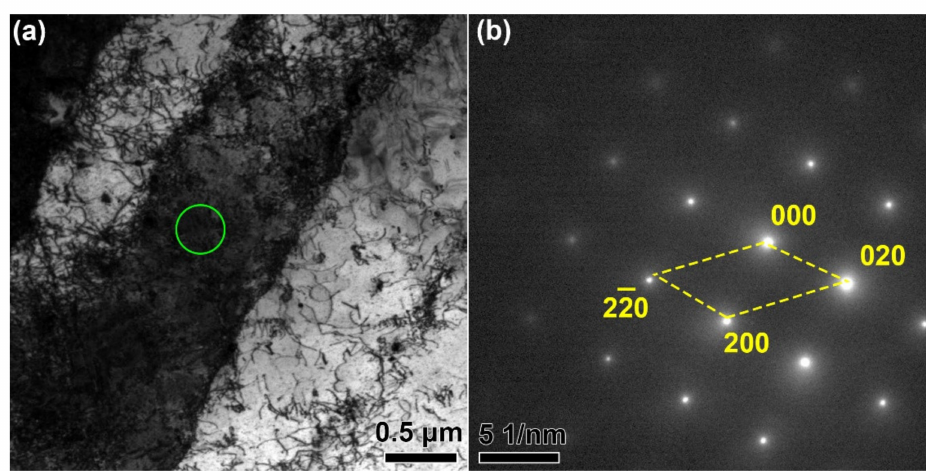
Figure 4. TEM images showing the microstructure of as-built GTD222. ( a ) The bright field image of the GTD222, ( b ) selected area electron diffraction of green circle area marked in ( a ). In the HTed GTD222, the tangled dislocations were disappeared and γ ’ was precipi- tated, as shown in Figure 5a,b. The precipitated γ ’ was further identified by the dark-field image and the selected area electron diffraction of green circle area marked in Figure 5b, as displayed in Figure 5c,d.